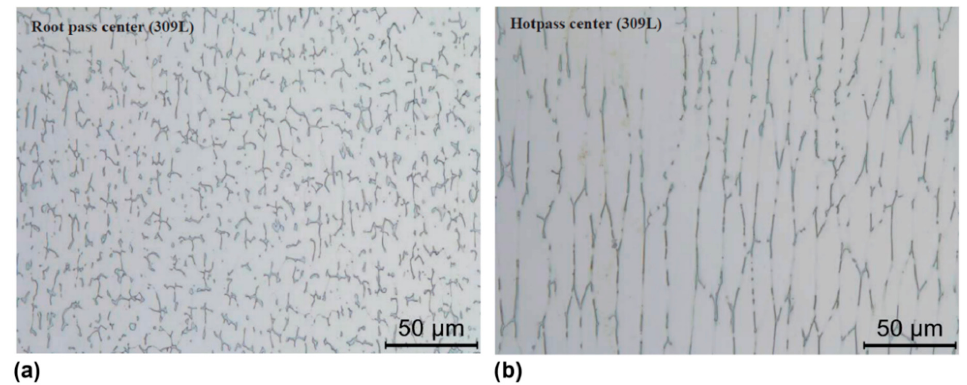
Figure 12. Microstructure in the weld metal ( a ) root pass and ( b ) hot pass centers etched with oxalic acid